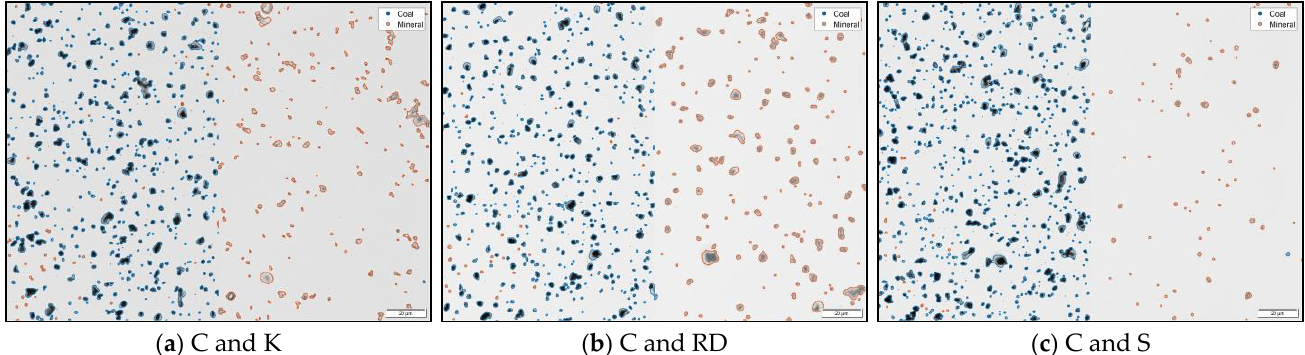
Figure 6. Example of the transmitted light AMPI classification model results on dual images with only coal particles on the left side and only mineral particles on the right side. The mineral particles were ( a ) kaolinite, ( b ) rock dust, and ( c ) silica. The classification results are superimposed on the same TPP images shown in Figure 4. Particles classified as coal are shown with blue boundaries and those classified as mineral are shown with orange boundaries. Sample types are abbreviated as C: Coal; K: Kaolinite; RD: Rock dust; and S: Silica.